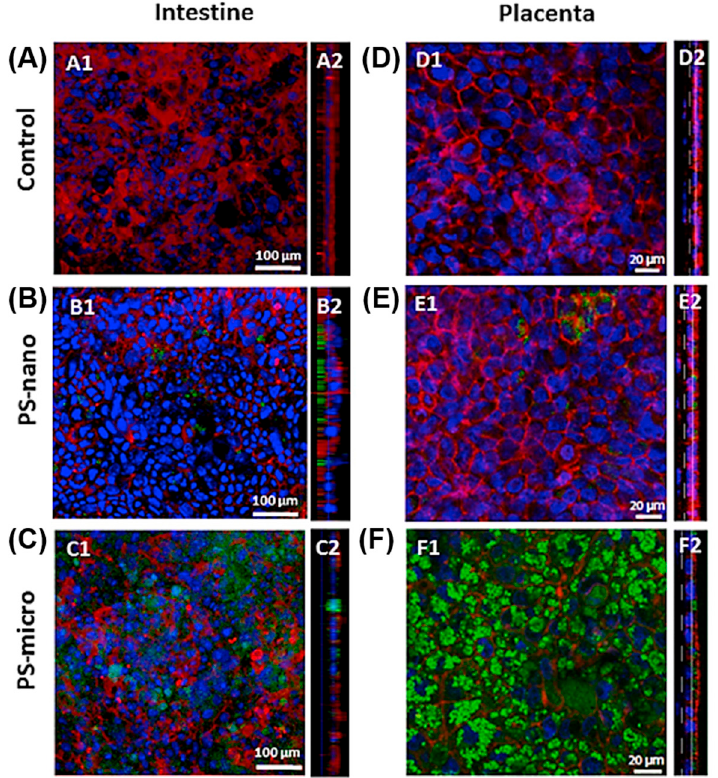
Figure 10. Internalization and intracellular distribution of PS NPs and PS MPs in intestinal and placental cocultures. Caco-2/HT29-MTX-E12 ( A – C ) and BeWo b30/HPEC-A2 ( D – F ) cocultures were observed by confocal microscopy after exposure to PS NPs ( B , E ) and PS MPs ( C , F ) (100 μ g/mL) for 24 h. Cells were stained with phalloidin (actin, red) and Dapi (nuclei, blue), whereas PS particles (Rhodamine 6G) were fluorescently labeled (green). Also, A1–F1 show single z-plane of the cell layer, while A2–F2 showx-z-cross-section views [21]. (Reprinted with permission from [21]. Copyright 2017 Elsev.)